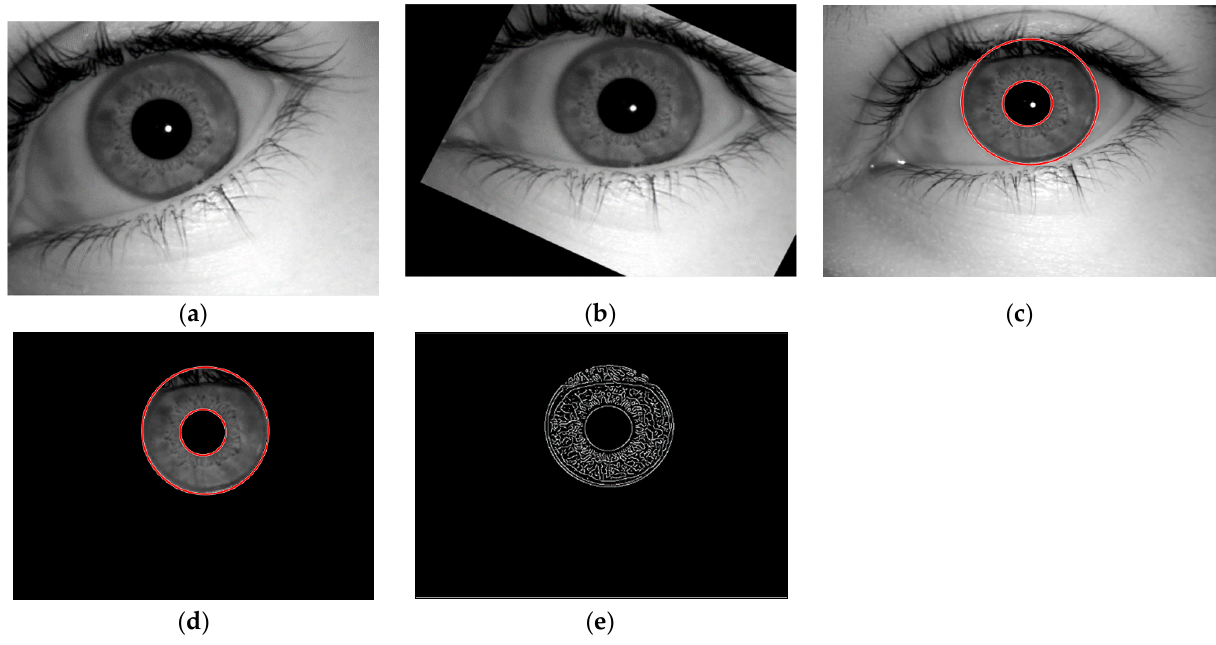
Figure 11. ( a ) Original eye image. ( b ) Image after registration. ( c ) Outer and inner boundaries of image. ( d ) Iris portion separation from an eye image. ( e ) Features of an Iris. image. ( d ) Iris portion separation from an eye image. ( e ) Features of an